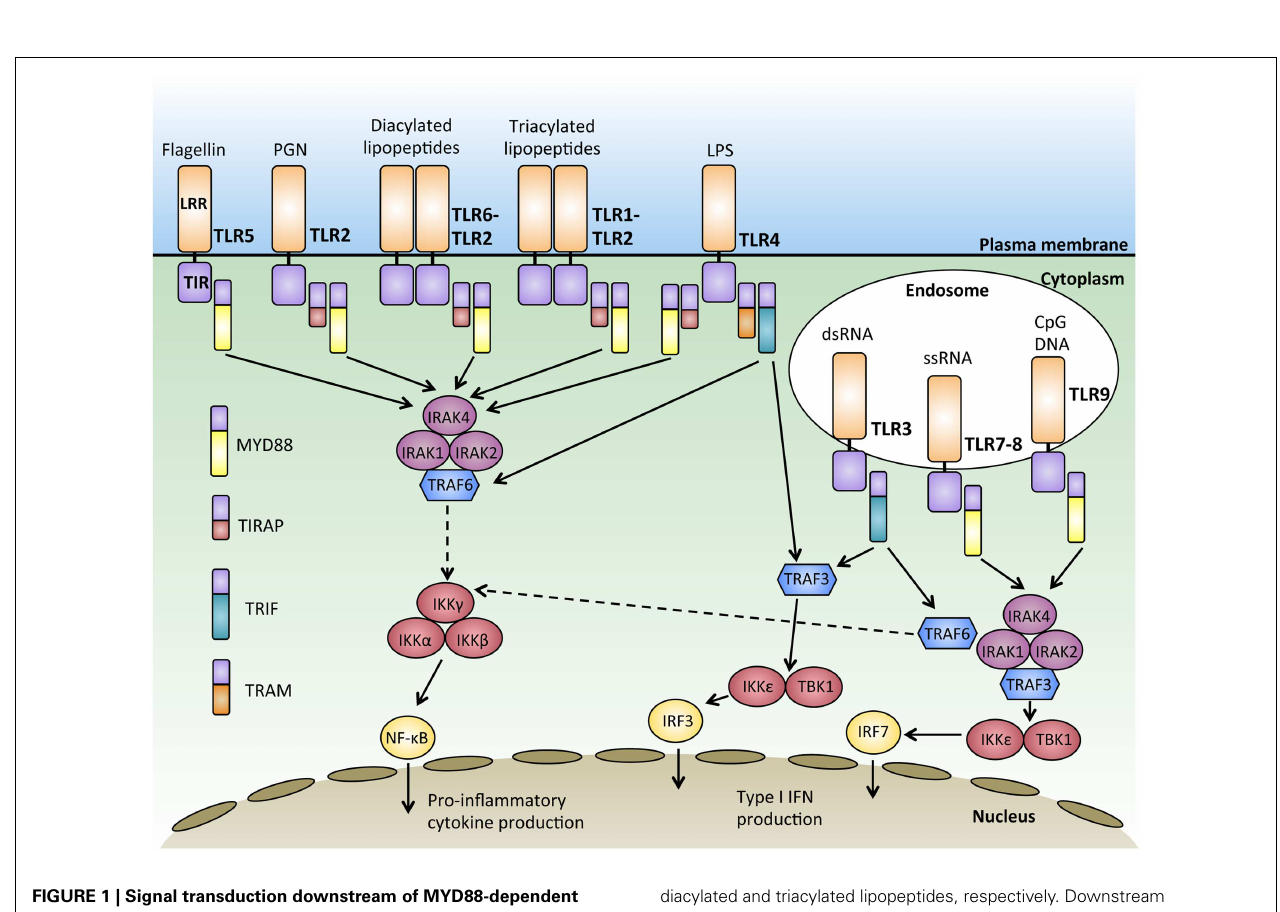
FIGURE 1 | Signal transduction downstream of MYD88-dependent and independent pathways . Activation ofToll-like receptors (TLRs) through binding of their ligand leads to receptor dimerization and the recruitment of adaptor proteins such as MYD88,TIRAP,TRIF, and TRAM. Most of theTLRs form homodimers upon activation whileTLR2 can also form heterodimers with eitherTLR6 orTLR1 to recognize